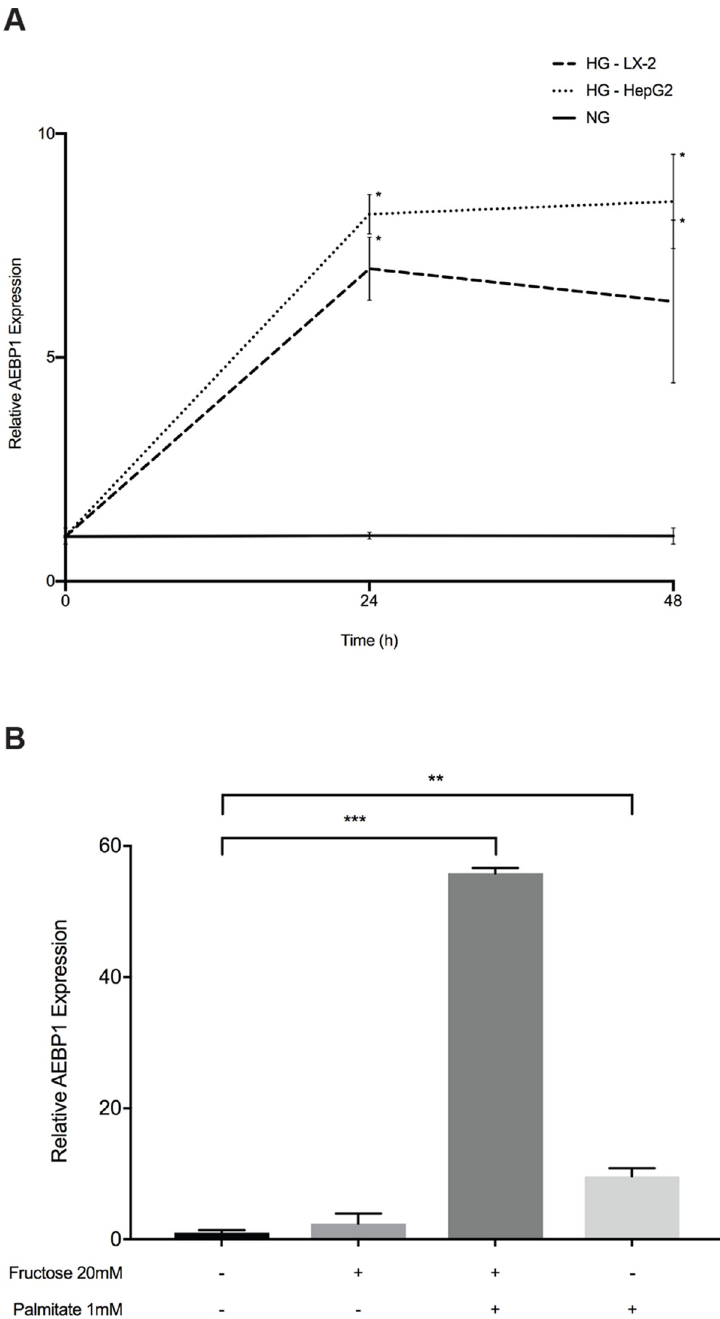
Fig 3. Effect of glucose, palmitate, and fructose on AEBP1 expression. LX-2 and HepG2 cells were serum-starved for 24 hours to arrest and synchronize cell growth. After this time, cells were grown in medium supplemented with 5% FBS, containing either normal glucose (NG: 5.5 mM) or high glucose (HG: 25 mM) for 24 or 48 hours. A) Relative quantification of AEBP1 transcript levels was performed using quantitative PCR. AEBP1 expression levels were normalized using GADPH , setting values to one under NG conditions at each time point. Data are presented as mRNA fold-increase incubated under HG or NG conditions. Results represent average of three independent experiments. Data are mean ± SD. � P < 0.05. B) Primary human hepatocytes were treated with 1 mM BSA-conjugated palmitate, 20 mM fructose, or a combination of the two for 48 hours. The black bar represents treatment with BSA-only. All experiments were performed in triplicate. Data are mean ± SD. Differences between conditions were assessed using one-way ANOVA test with a Dunnett’s multiple comparison post-test. �� P < 0.005; ��� P < 0.0001.